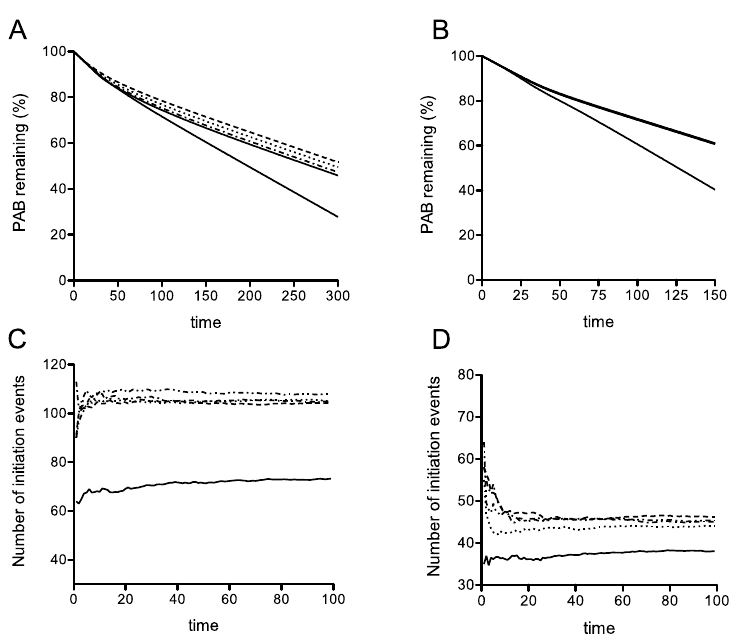
Figure 4. Model simulation of stop codon readthrough e ff ects. ( A ) Simulation of translation and mRNA decay using an initial framework where ribosomal queuing is not permitted. Shortening of the poly(A) tail, and thus proportion of bound poly(A) binding protein is used as a proxy for mRNA stability. Elongation and regular termination rate constants 10 times higher than the de-novo initiation rate constant and the total rate constant at the premature termination codon were used. The readthrough propensity used, 0.5, does not result in significant stabilization of the C22 early PTC variant (solid, lower line). ( B ) Simulation of translation and mRNA decay using similar parameters as panel A, but with a framework where ribosomal queuing is now permitted. A readthrough propensity of 0.9 was used, while keeping the total rate constant at the premature termination codon fixed. Note that decreasing the total rate constant at the premature stop codon can accentuate the queueing e ff ect. The solid lower line represents the C22 allele. ( C , D ) Stochastic simulations show similar patterns of stability. In each case, the solid, lower line represents the stability plot for the early, codon 22 proxy stop codon. A recycle propensity of 0.1 was used for the codon 22 proxy, with a 0.9 recycle propensity used of all other premature termination codons. Simulation of a non-queuing regime was performed with 50% stop codon readthrough ( C ) or with a queuing regime and 90% readthrough ( D ).